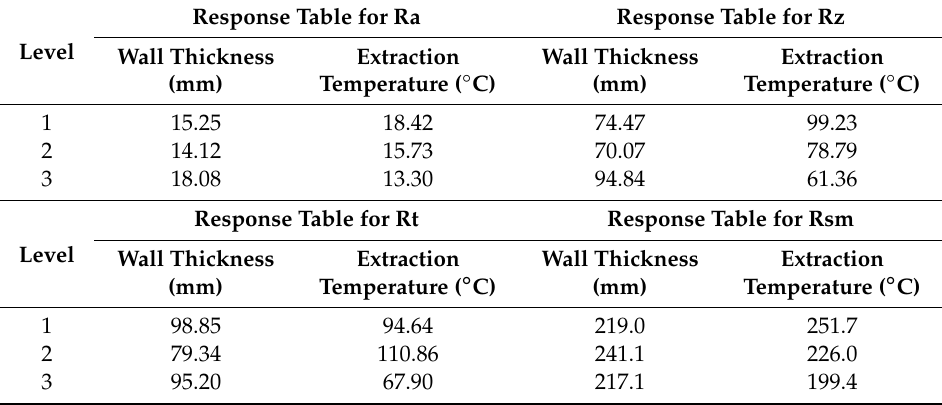
Table 7. Mean values for surface roughness.